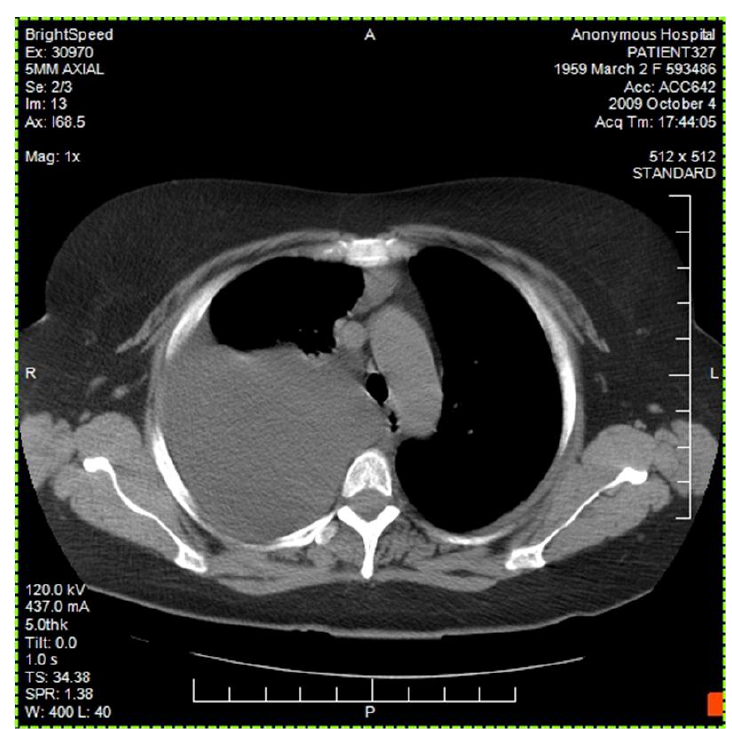
FIGURE 3 . Axial thoracic CT showing right-sided pleural